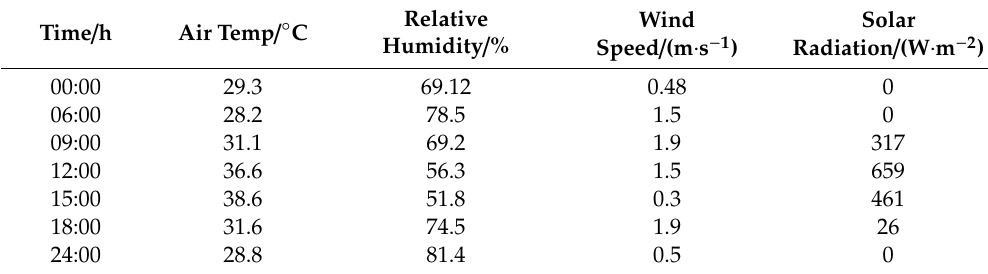
Table 2. Environmental parameters at partial time.